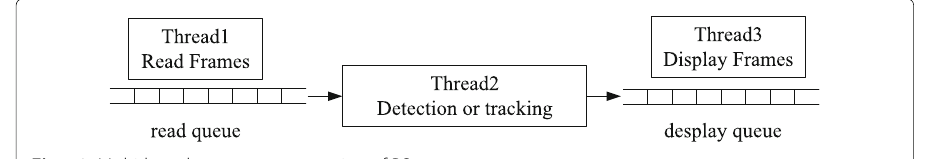
Fig. 10 Multithread concurrent execution of